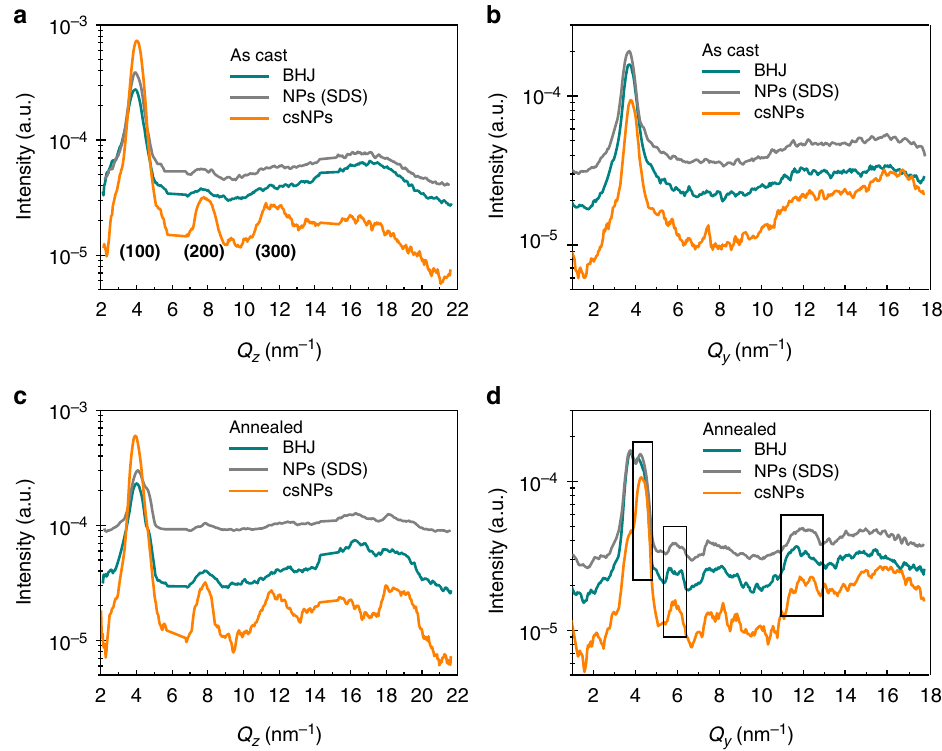
Fig. 3 Grazing-incidence wide-angle X-ray scattering (GIWAXS) of cs-NP fi lm. The GIWAXS pro fi les of P3HT:o-IDTBR obtained from BHJ fi lm processed from THF solution, NP (SDS)-based fi lm and cs-NP-based fi lm, respectively. As cast fi lms collected from a out-of-plane cuts at Q y = 0 and b in-plane cuts at Q z = 0 as well as annealed fi lms (150 °C, 10 min) collected from c out-of-plane cuts at Q y = 0 and d in-plane cuts at Q z = 0